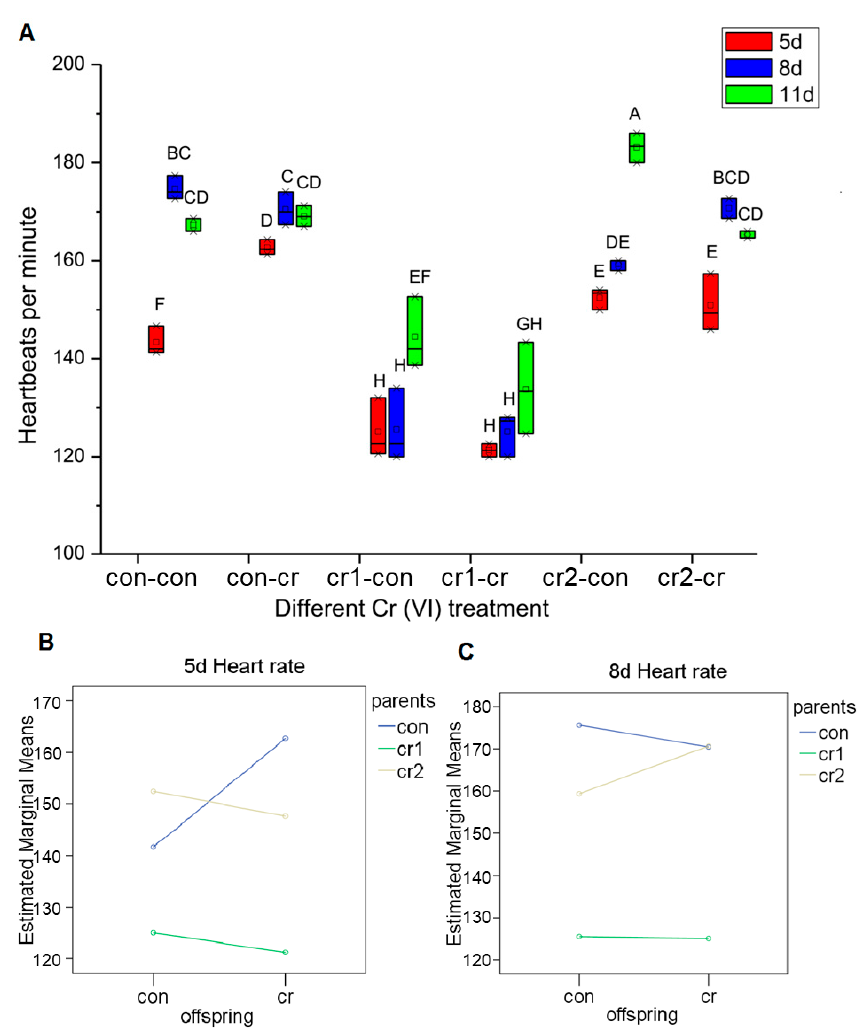
Figure 7. The change of heart rate after long-term Cr(VI) exposure in marine medaka offspring. ( A ) the heart rate for 5 d, 8 d and 11 day of offspring under different Cr(VI) treatment, different upper case means the significant differences among different treatment ( p ≤ 0.001); ( B , C ) the interaction of parent and offspring Cr(VI) treatment for heart rate; ( B ) 5 d heart rate ( p = 0.000); ( C ) 8 d heart rate ( p = 0.031). The number of biological samples used for each group is as follow: con-con ( N = 14), con-cr ( N = 25), cr1-con ( N = 9), cr1-cr ( N = 9), cr2-con ( N = 3), cr2-cr ( N = 3).